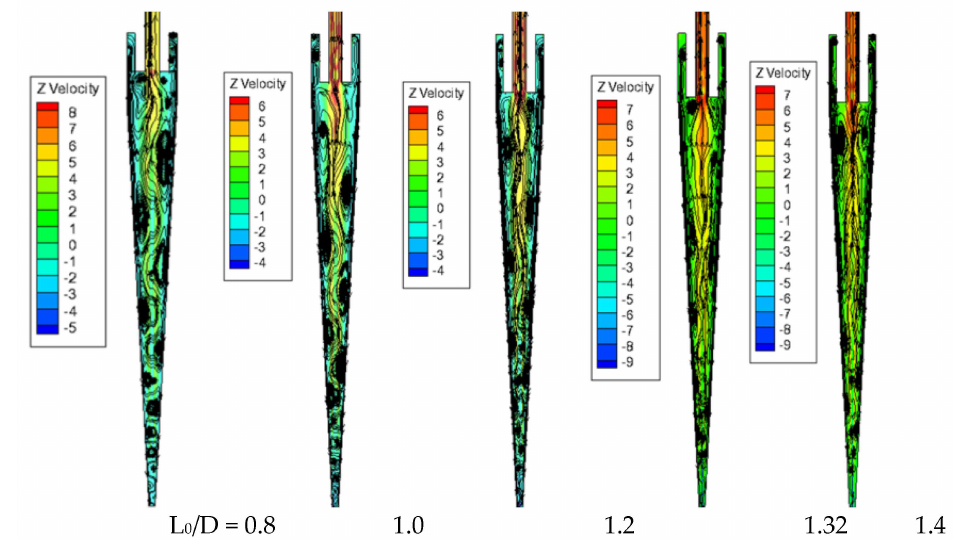
Figure 9. Streamline diagram of mini-hydrocycloness with different vortex finder depth.